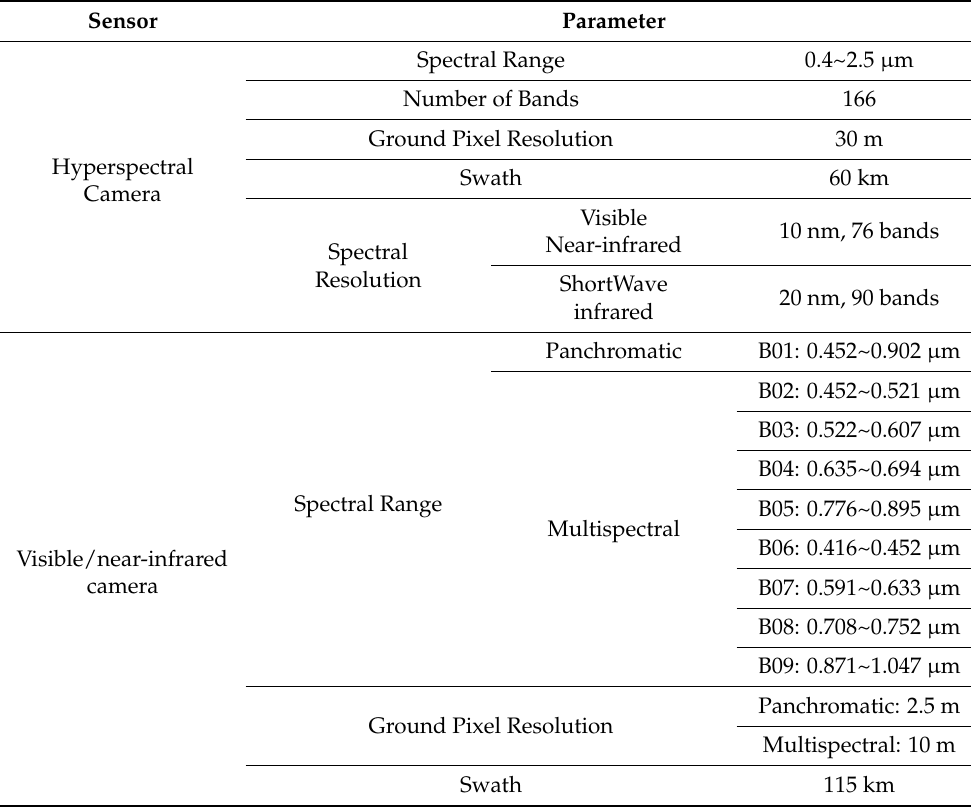
Table 1. Parameters of